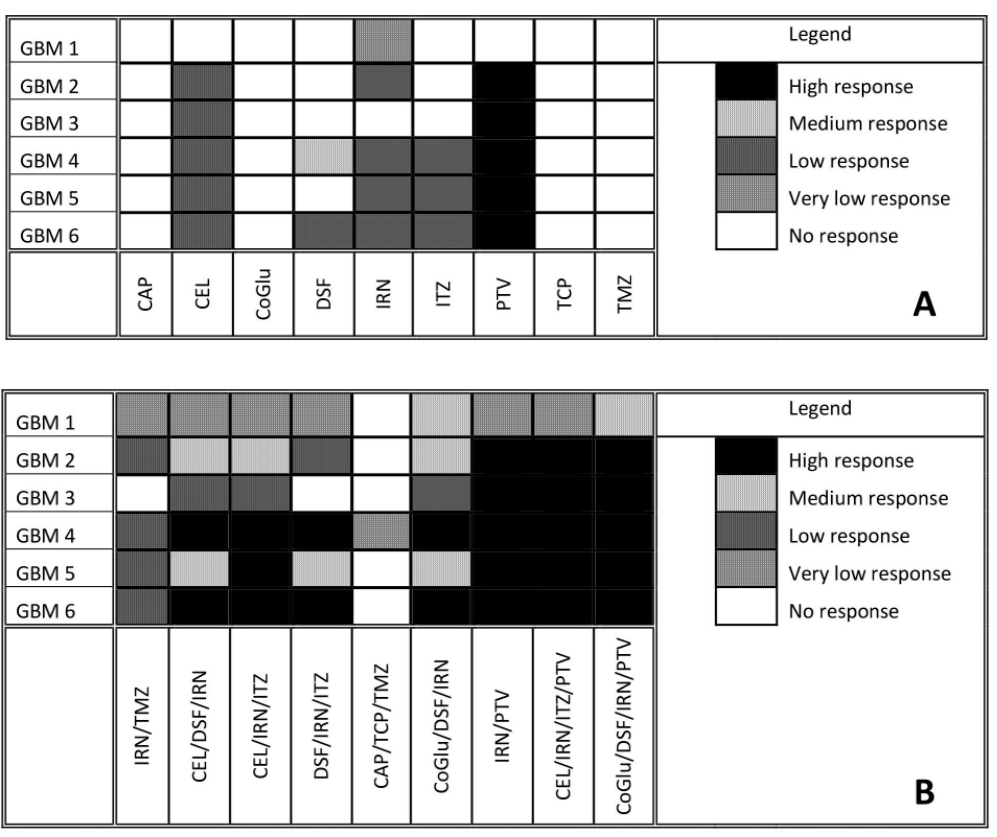
Figure 3. Response of GBM cells to each individual drug after five days of incubation ( A ). Response of GBM cells to a series of personalised, random and clinically relevant drug combinations ( B ). If the drug failed to achieve an IC 50 then the response was defined a no response. A high response corresponds to an IC 50 value between 2 and 3 Log nM, a medium response between 3 and 4 Log nM, a low response between 4 and 5 Log nM and very low above log 5 nM.